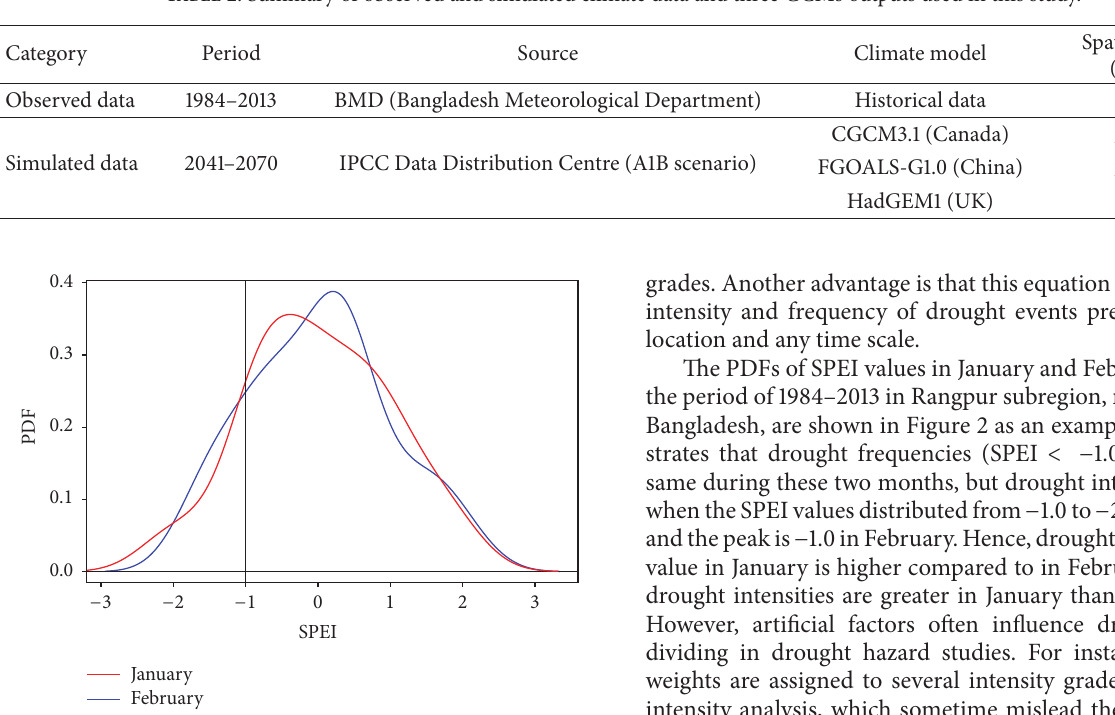
Table 2: Summary of observed and simulated climate data and three GCMs outputs used in this study.